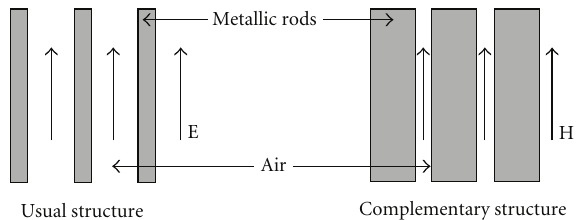
Figure 3: Directivity and radiation bandwidth.